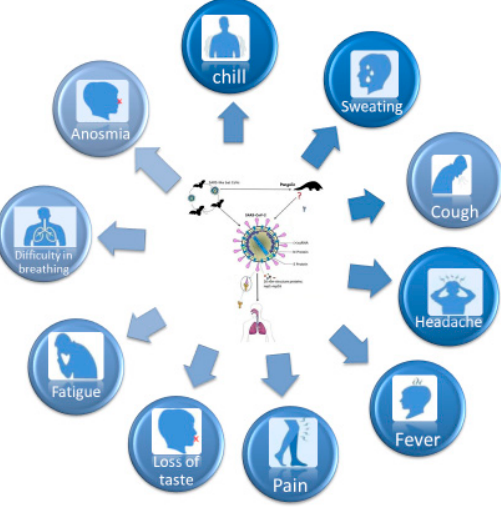
Figure 5. The specific Symptoms for COVID-19 (figure drawn by Giovanna Dipalma) .